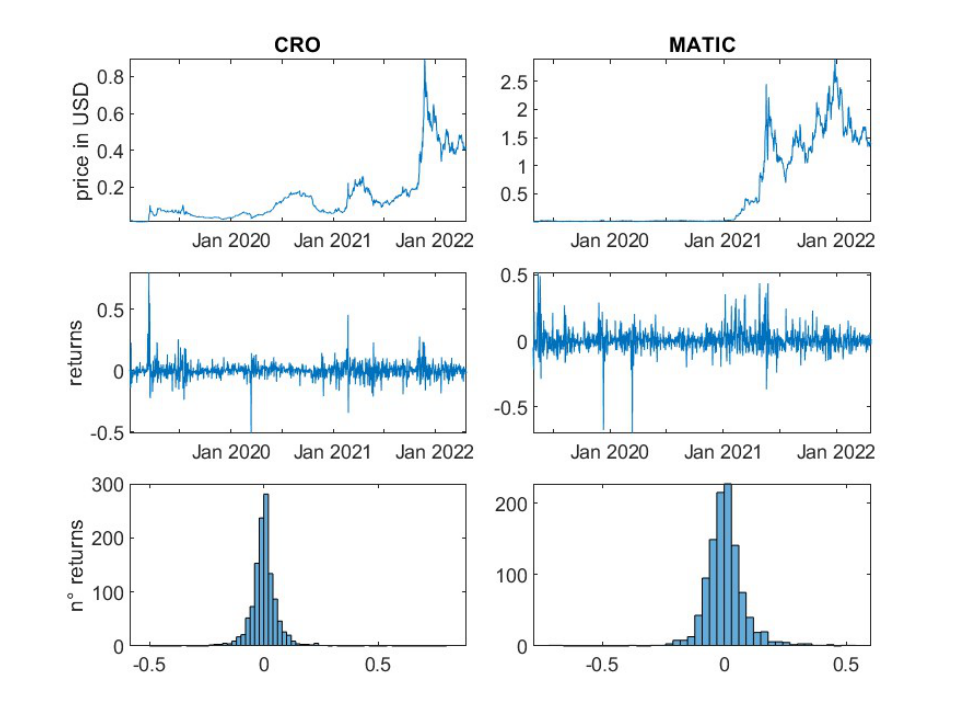
Figure A7. CRO and MATIC daily logarithmic